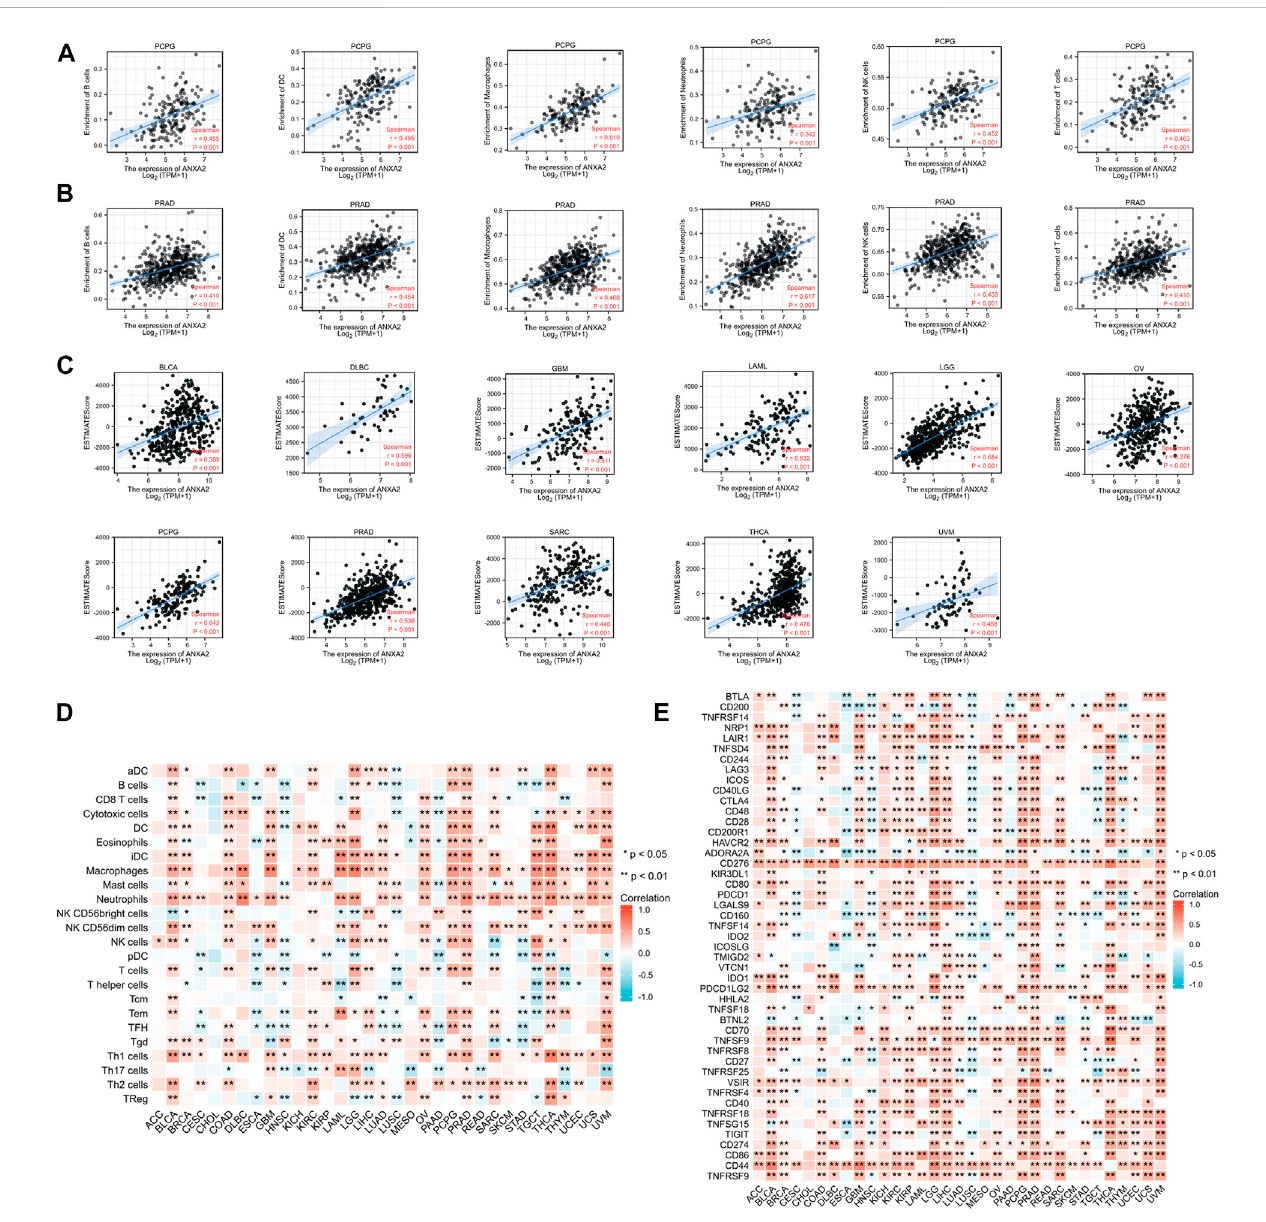
FIGURE 6 Correlation analysis of ANXA2 gene expression in immune cell in fi ltration, 47 immune checkpoints and ESTIMATEScore. (A,B) Correlation between ANXA2geneexpressionandsiximmunecells(Bcells,dendriticcells,macrophages,neutrophils,NKcellsandTcells)inPCPGandPRAD. (C) ANXA2expression signi fi cantly correlatedwiththeESTIMATEScorein23types ofcancer. (D) Correlationbetween ANXA2gene expression andin fi ltrationof24typesofimmune cells in 33 types of cancer. (E) Correlation between ANXA2 gene expression and 47 immune checkpoints in 33 types of cancer. * p < .05 and ** p <